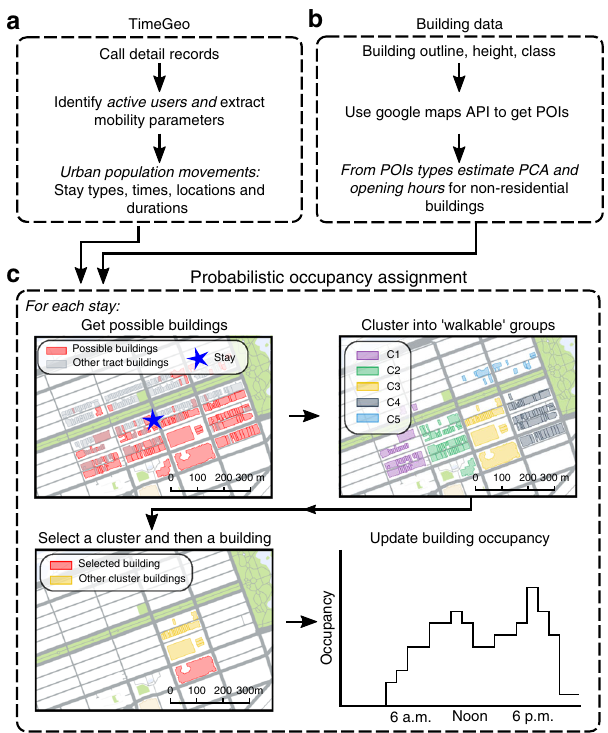
Fig. 3 CDR data and building data to building occupancy method. a The TimeGeo framework going from call detail records to population-wide stay locations 33 . b The building data includes building type, PCA and opening hours. c The set of possible buildings for a stay depends on building type and opening hours (for the stay type other as shown, possible buildings are open commercial buildings). Buildings are clustered into localized spatial groups using Ward ’ s minimum increase of variance method and the dendrogram is truncated at a Ward distance of 500 m, which yields city- block shaped clusters. Then, a cluster is probabilistically selected followed by a building, and the stay is added to that building ’ s occupancy pro fi